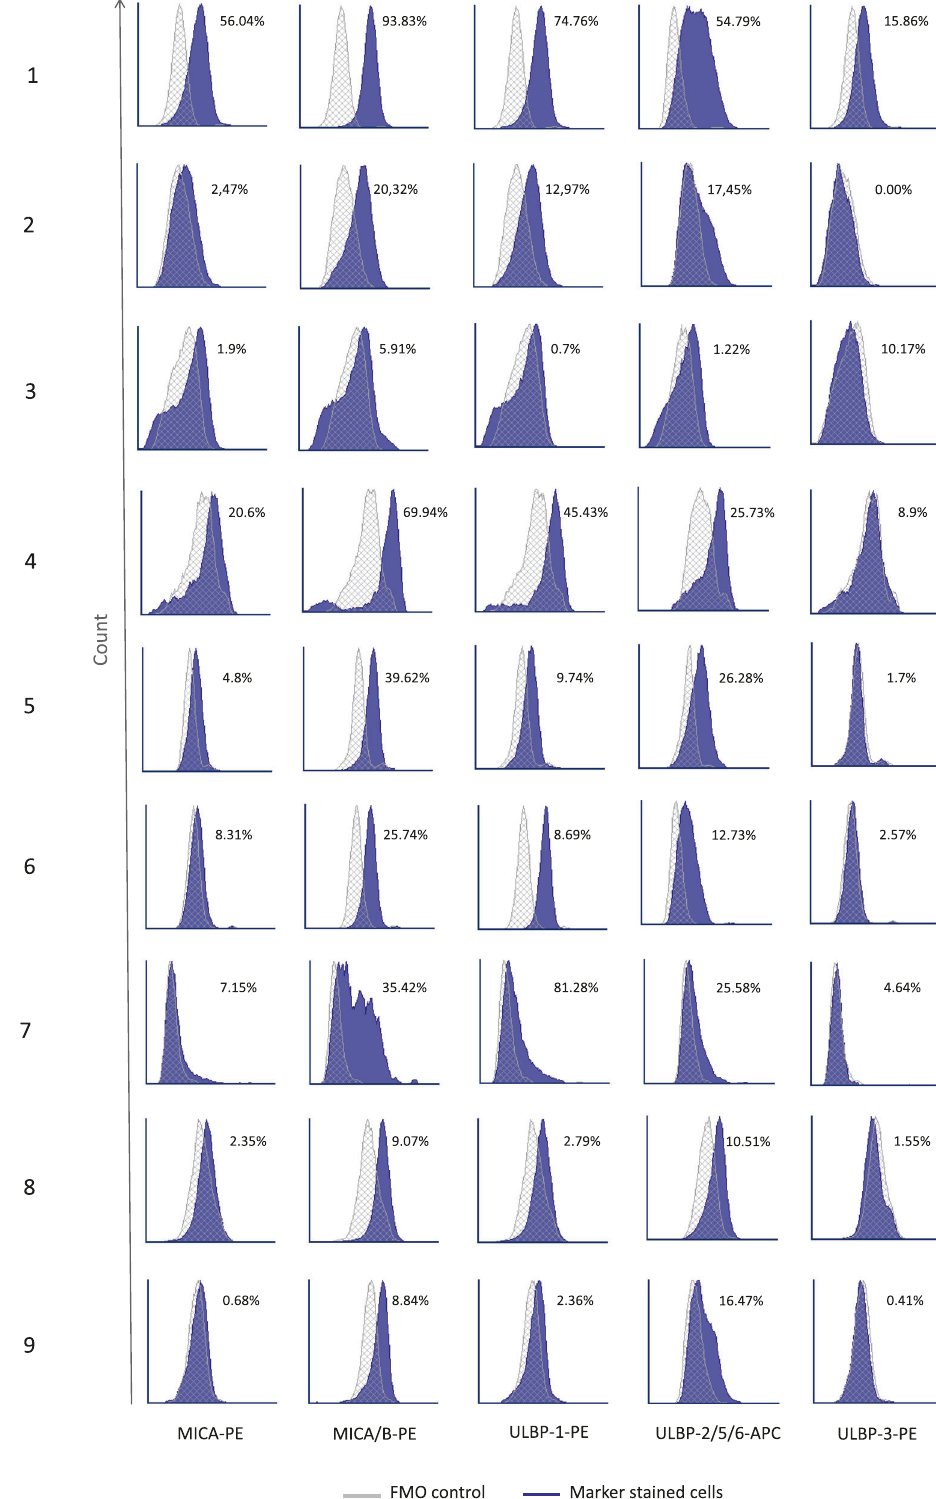
Fig. 1 NKG2D ligand expression in MM cells. Expressions of MICA, MICA/B, ULBP-1, ULBP-2/5/6, and ULBP-3 were analyzed in plasma cells from bone marrow samples of MM patients. Representative histograms are shown. For each staining, the percentages of positive cells versus the fl uorescence minus one (FMO) control are